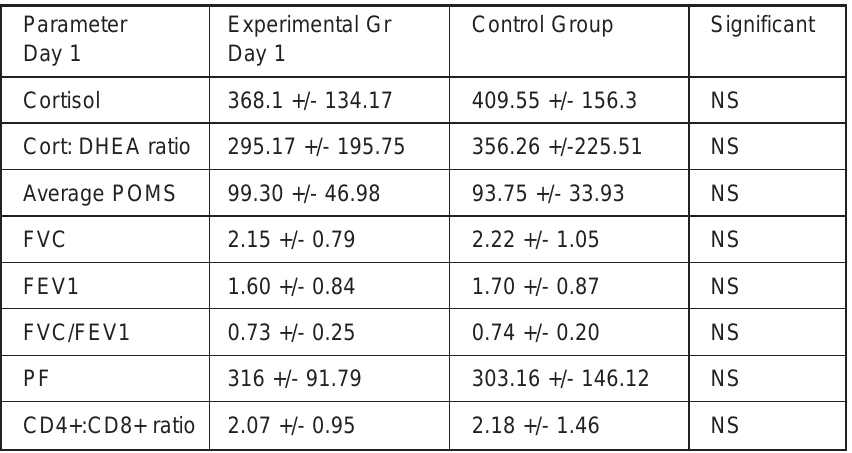
Table 1.2: Comparison of parameters between experimental and control groups